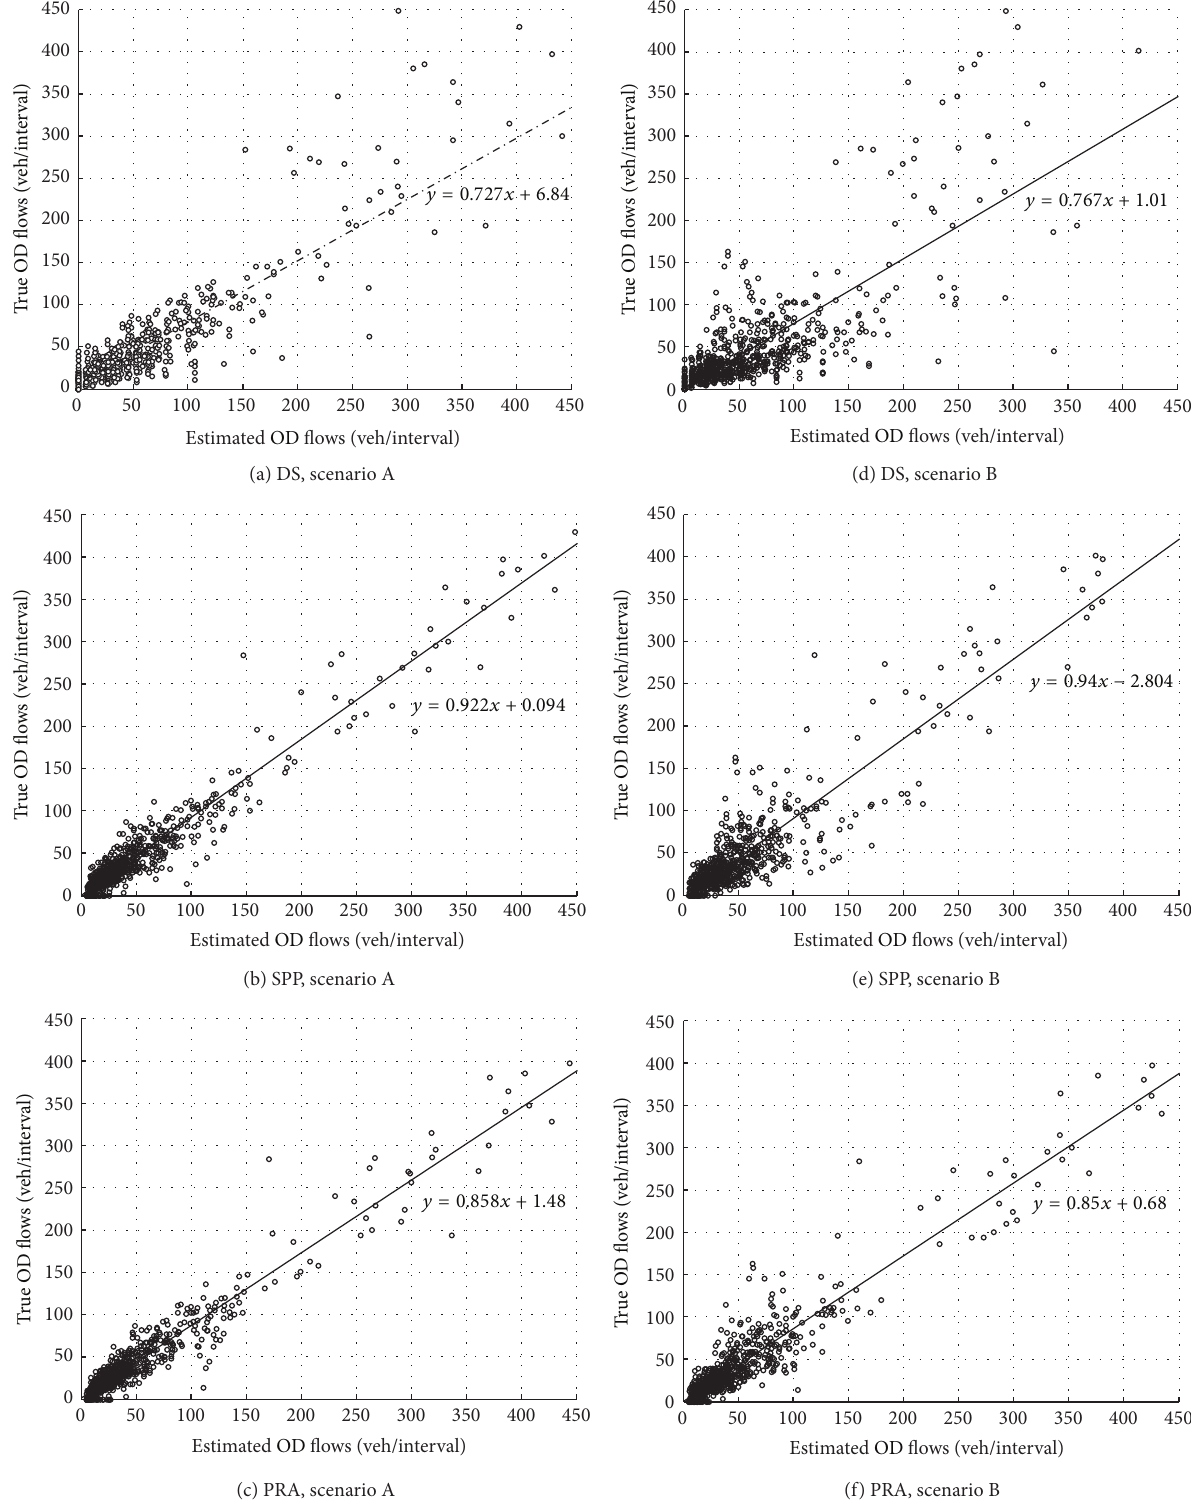
Figure 5: Scatter plots of estimated and ground truth OD